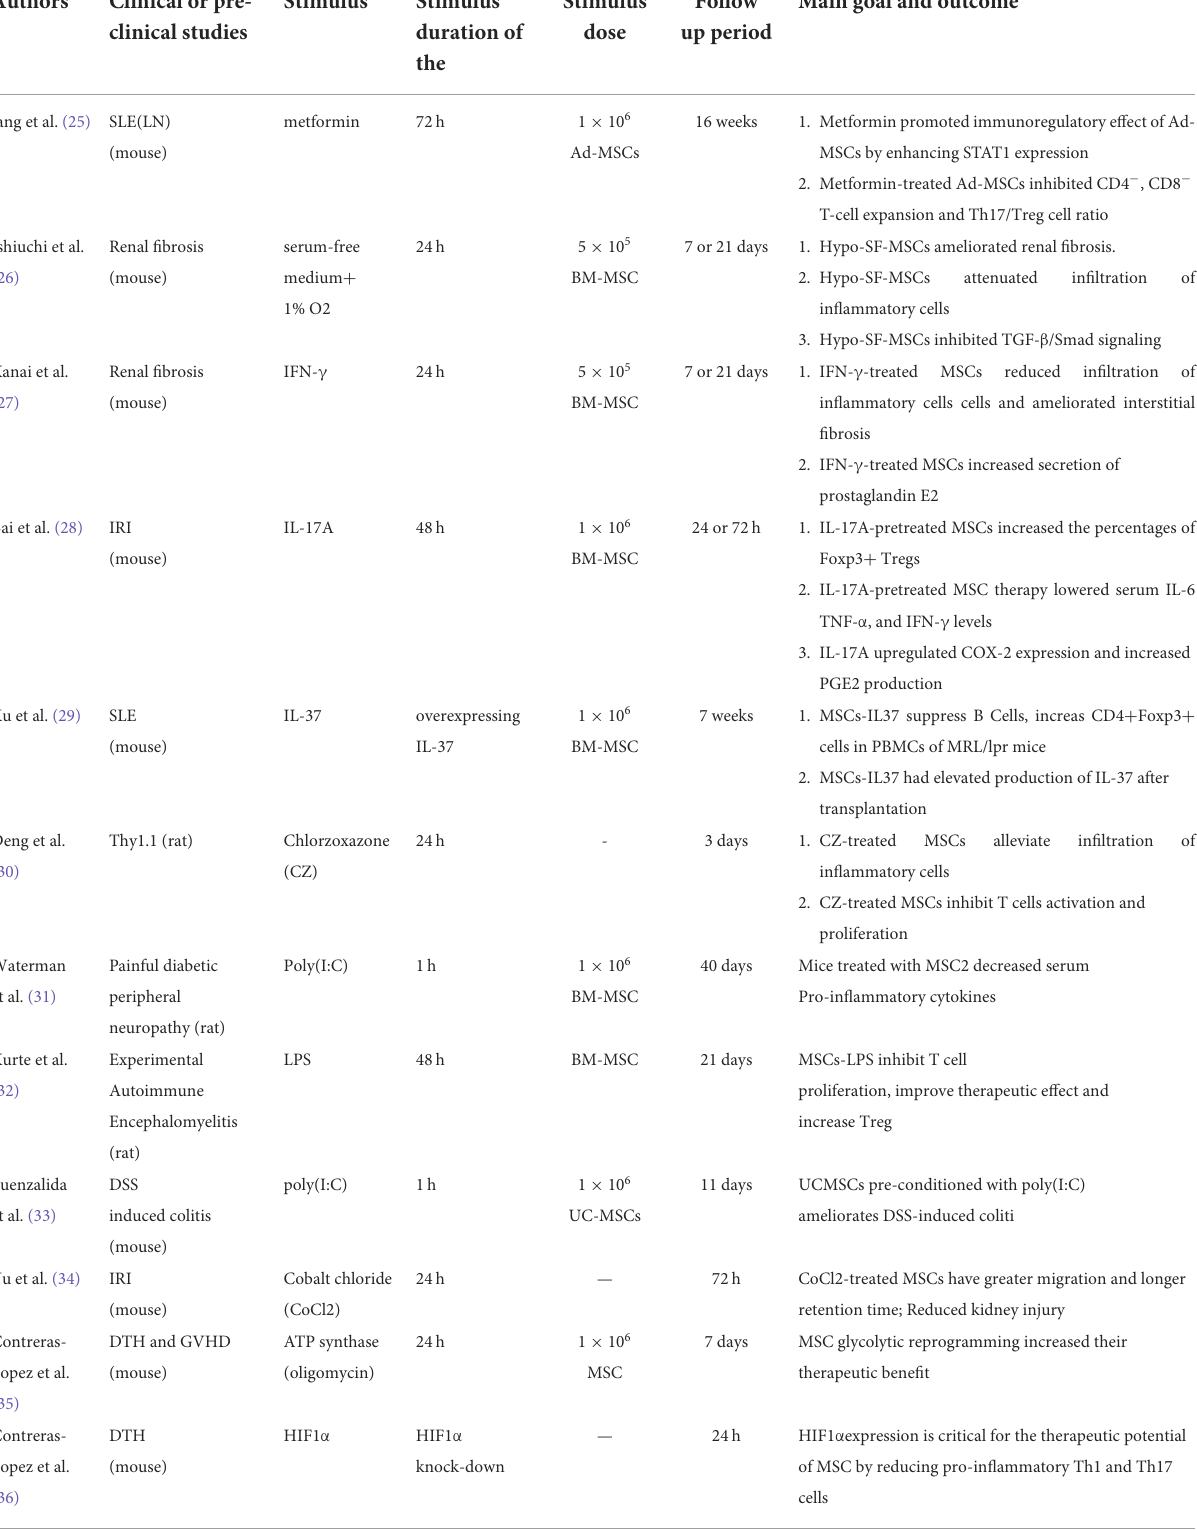
TABLE 1 The induction strategies of MSC2 and its applications in clinical or pre-clinical studies.